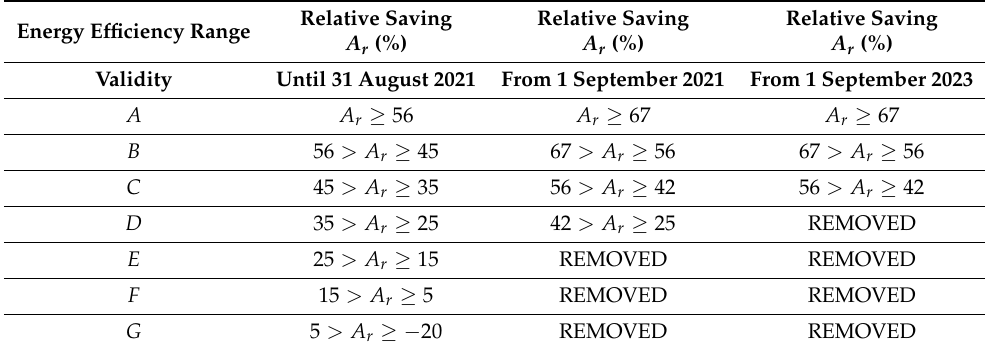
Table 2. Energy efficiency ranges for domestic refrigeration equipment for Colombia from 2021 to